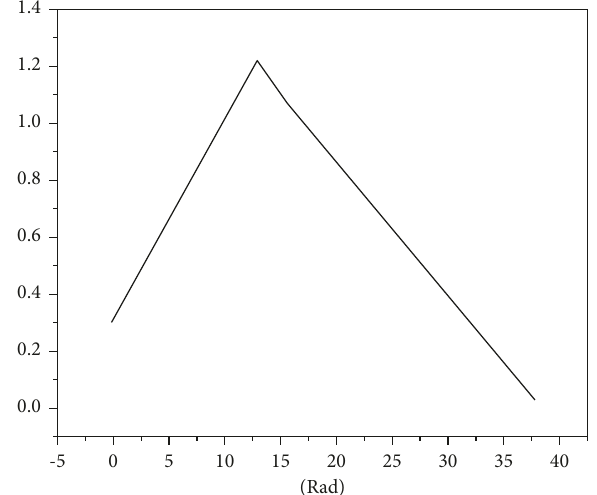
Figure 5: Comparison of vibration reduction performances of TMDI and TMD systems under moving